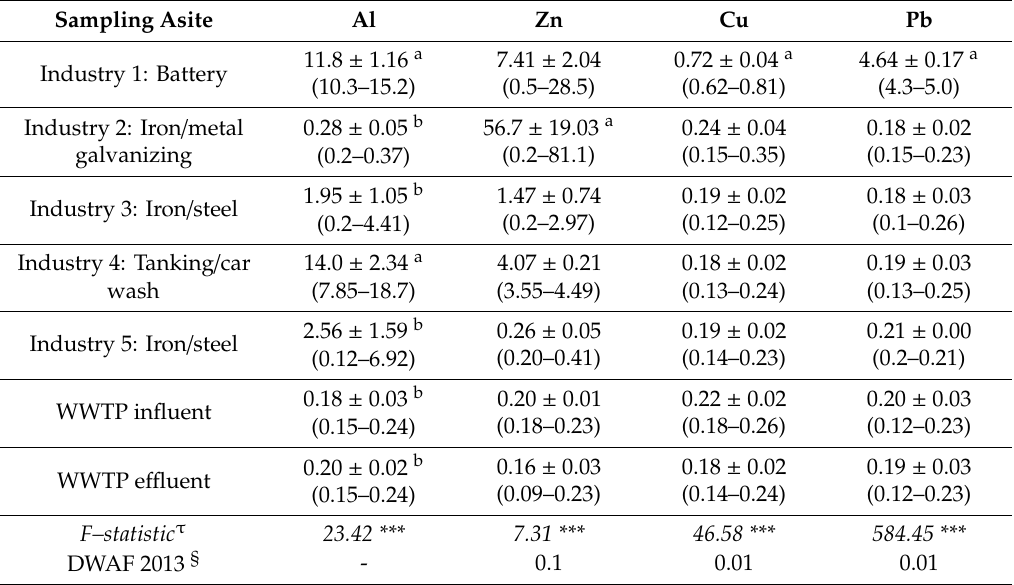
Table 2. Concentrations of major heavy metals (mg / L) in the di ff erent industrial wastewater and Leeuwkuil WWTP e ffl uents of the Vaal